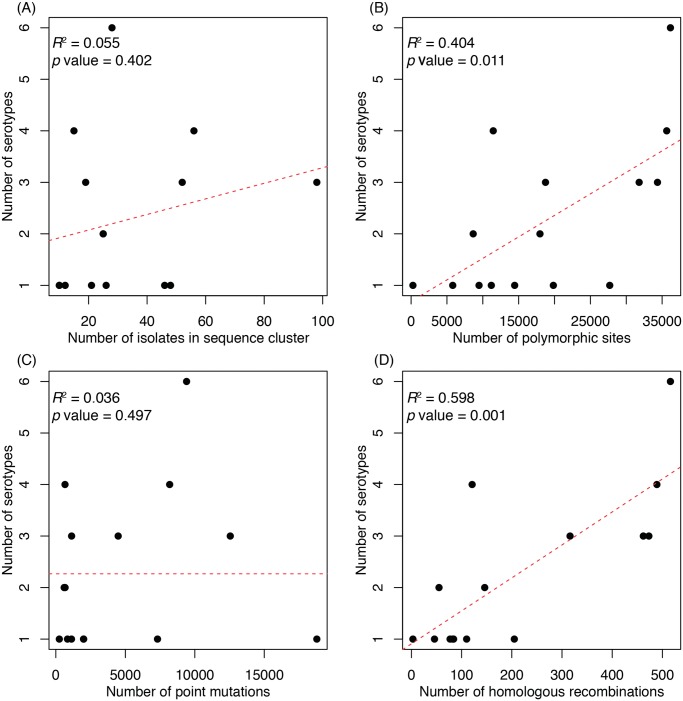
Associations between properties of a sequence cluster and its capsular diversity.For each of the fifteen monophyletic sequence clusters, the number of serotypes it contained was plotted against (A) the number of representatives of the sequence cluster; (B) the overall genetic diversity of the sequence cluster, as represented by the number of polymorphic sites identified from whole genome alignments; (C) the number of point mutations reconstructed as having occurred over the history of the sequence cluster; and (D) the number of homologous recombination events reconstructed as having occurred over the history of the sequence cluster.